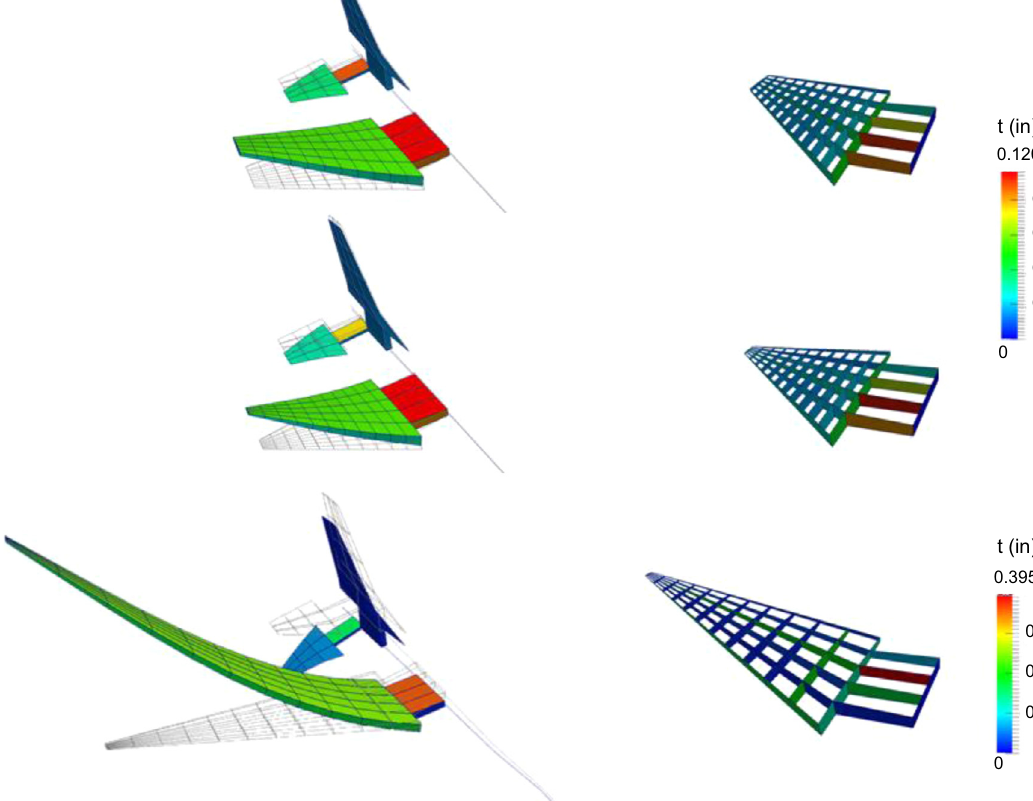
Figure 8. The ESAV planform and structural design thicknesses from the ASTROS structural sizing sub-optimization problem are shown above for the 1550 mi range baseline design (top row), the 1500 mi range design (middle row), and the 2500 mi range design (bottom row) optimal designs. (The left column shows the thicknesses for the wing skins and the right column shows the thicknesses of the ribs and